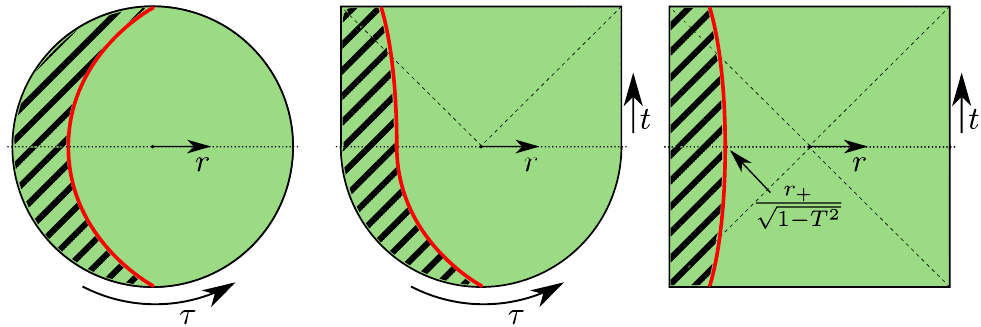
Figure 3 . Allowed positive tension brane configurations in the Euclidean/Lorenztian BTZ geometry. Left: The trajectory of the End-of-The-World (ETW) brane (red) in the Euclidean geometry. Middle: Euclidean preparation of the Lorentzian ETW brane BTZ state. Right: Full Lorenztian solution of ETW brane BTZ black hole. The shaded region is the excluded region of the original eternal BTZ black hole